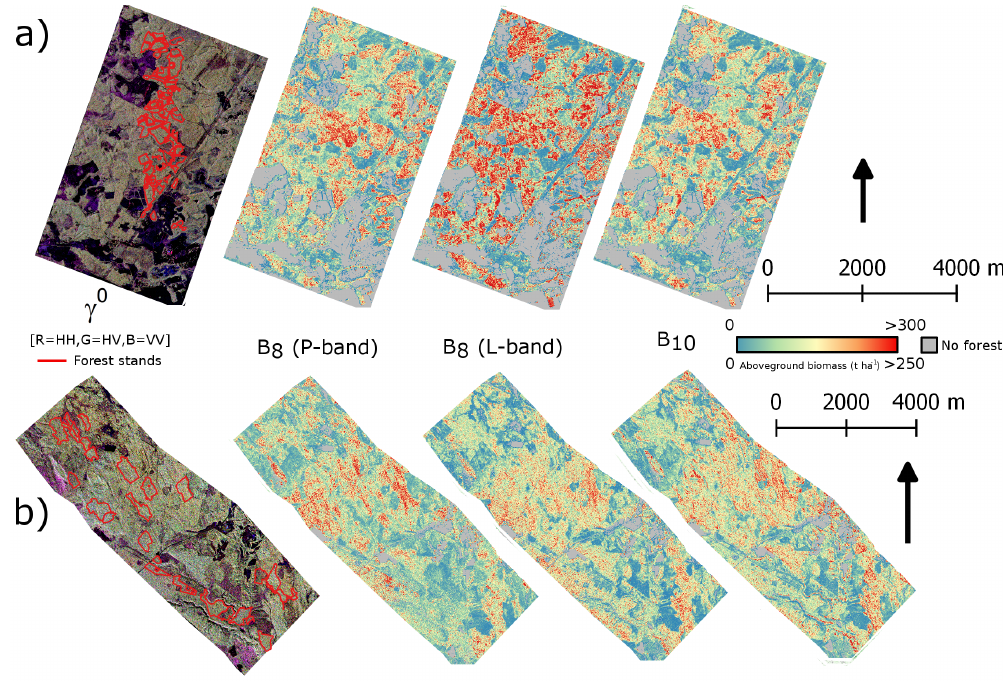
Figure 6. Spatial representation of L-band backscatter coefficient γ 0 with location of forest stands, aboveground biomass estimated with backscatter and PolInSAR height at P- and L-band (center) and biomass model combining the two bands (right) in Remningstorp ( a ) and Krycklan ( b ). Please note that the aboveground biomass of the stands ranged to 183 t ha − 1 in Krycklan and 287 t ha − 1 in Remningstorp and thus, estimations above these values may not be reliable.